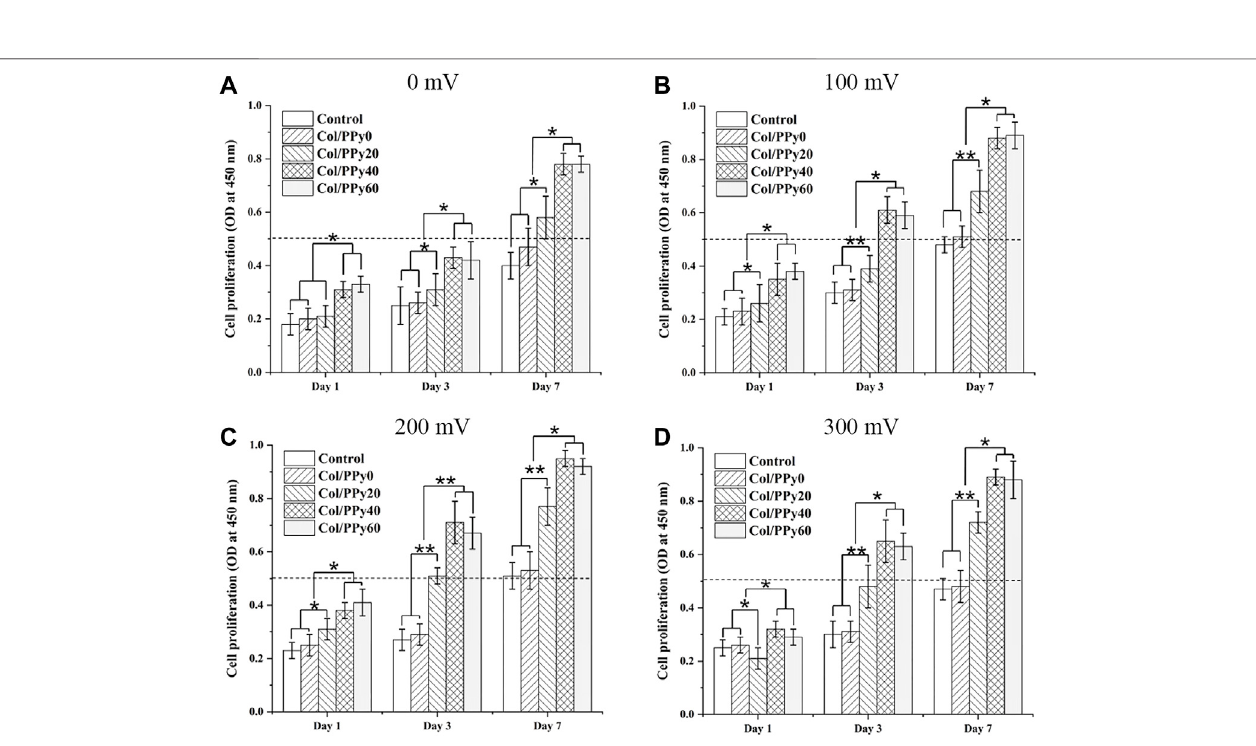
FIGURE5| Cellproliferationassay.ProliferationofNSCsondifferentCol/PPyhydrogelsonthe fi rst,third,andseventhdaysafterelectricalstimulationwithdifferent voltages (A) : 0 mV, (B) 100 mV, (C) 200 mV, (D) 300 mV).